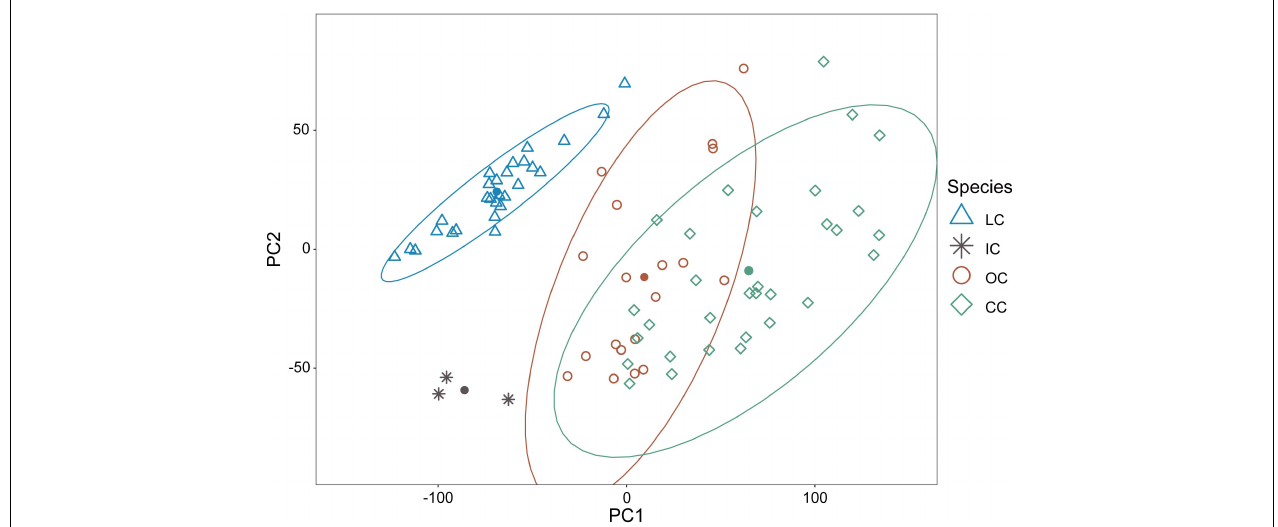
FIGURE 6 | The score plot of PC1 versus PC2 of the principal component analysis for the 11 morphology features of the four Cuculus cuckoos. PC1 explains 72.5% of the total variations while PC2 explains 19.3% of the total variations in the data. The shapes and colors of the dots are different according to species. LC, lesser cuckoos; IC, Indian cuckoos; OC, oriental cuckoos; CC, common cuckoos. Close circles are centroid vale (PC1 and PC2) of each species.